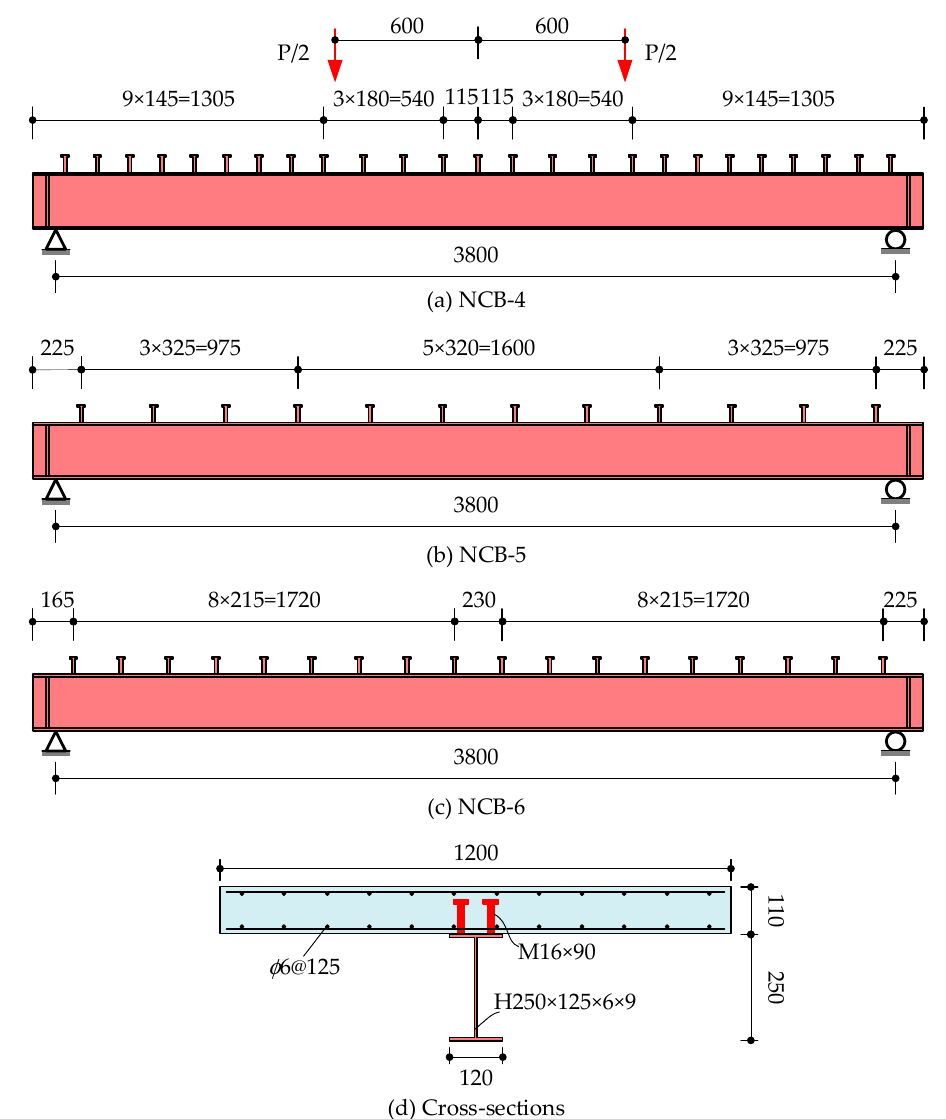
Figure 9. Structural details of specimens NCB-4, NCB-5 and NCB-6. Table 1. Material properties of steel in NCB-4, NCB-5 and NCB-6.